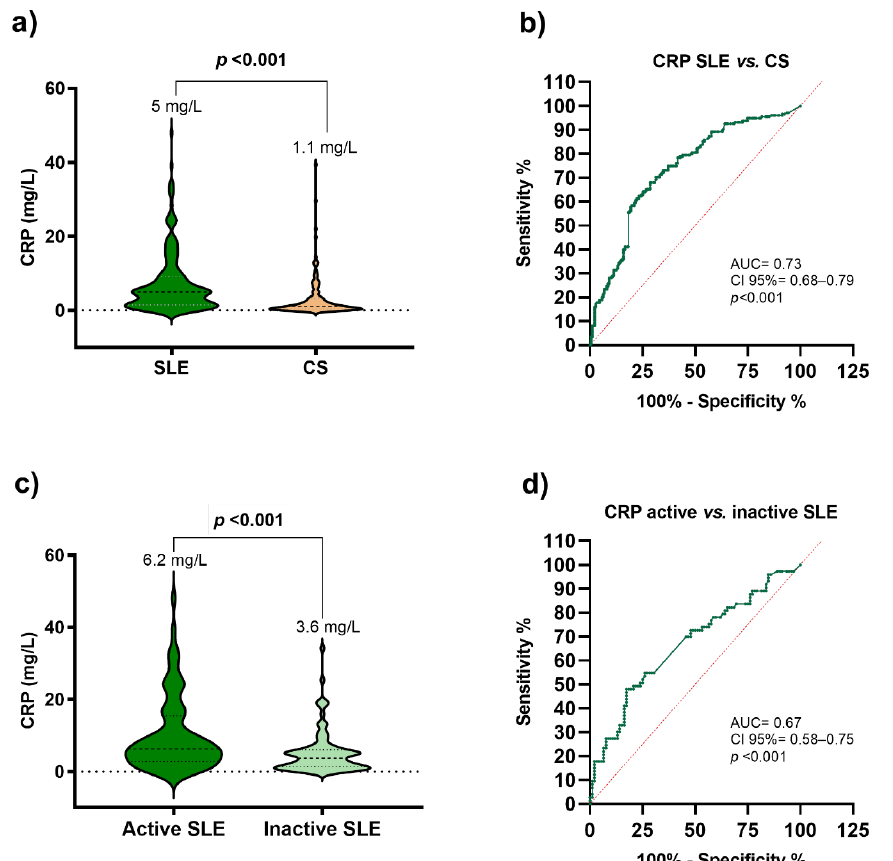
Figure 1. Serum CRP levels were stratified by study groups. ( a ) Serum CRP levels in SLE patients and CS. Data presented as median; p value U Mann–Whitney test. SLE: systemic lupus erythematosus patients; CS: control subjects; CRP: C-reactive protein. ( b ) Discriminatory receiver operating characteristic (ROC) curve between SLE patients vs. CS. AUC = area under the curve. 95% CI = 95% confidence interval. ( c ) Serum CRP levels stratified by clinical disease activity in SLE patients. Clinical inactivity: Mex-SLEDAI < 2; Clinical activity: Mex-SLEDAI ≥ 2. Data provided in median; p value U Mann–Whitney test. ( d ) Discriminatory receiver operating characteristic (ROC) curve between inactive vs . active SLE patients.